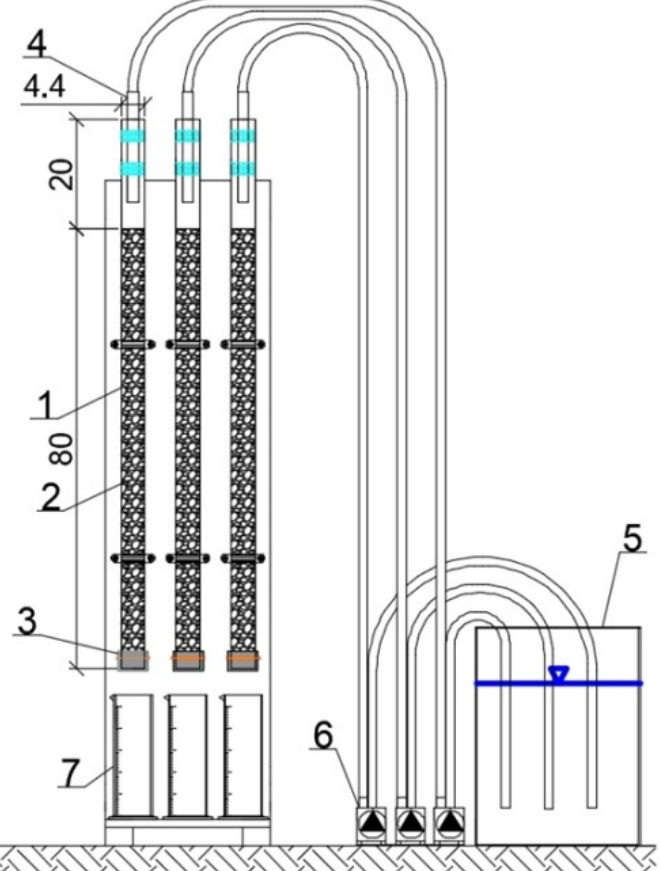
Figure 1. Experimental set-up: (1—transparent acrylic glass tube ( L = 100 cm; D in = 4.4 cm); 2—bed of xylit with a height of 80 cm; 3—safety net (mosquito net) with a mesh size of 1.0 × 1.0 mm; 4—fountain pump sprinkler located centrally in relation to the pipe with a 5.0 cm sponge above the surface of the filling; 5—wastewater tank with a capacity of 30 dm 3 ; 6—pump; 7—collecting and measuring vessel).